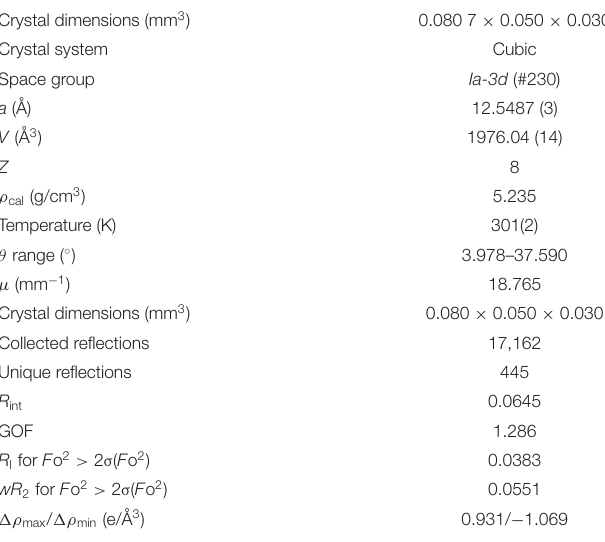
TABLE 1 | Results of structural refinement of Ce 2 CaMg 2 Ge 3 O 12 using single-crystal XRD data. Crystal dimensions (mm 3 )